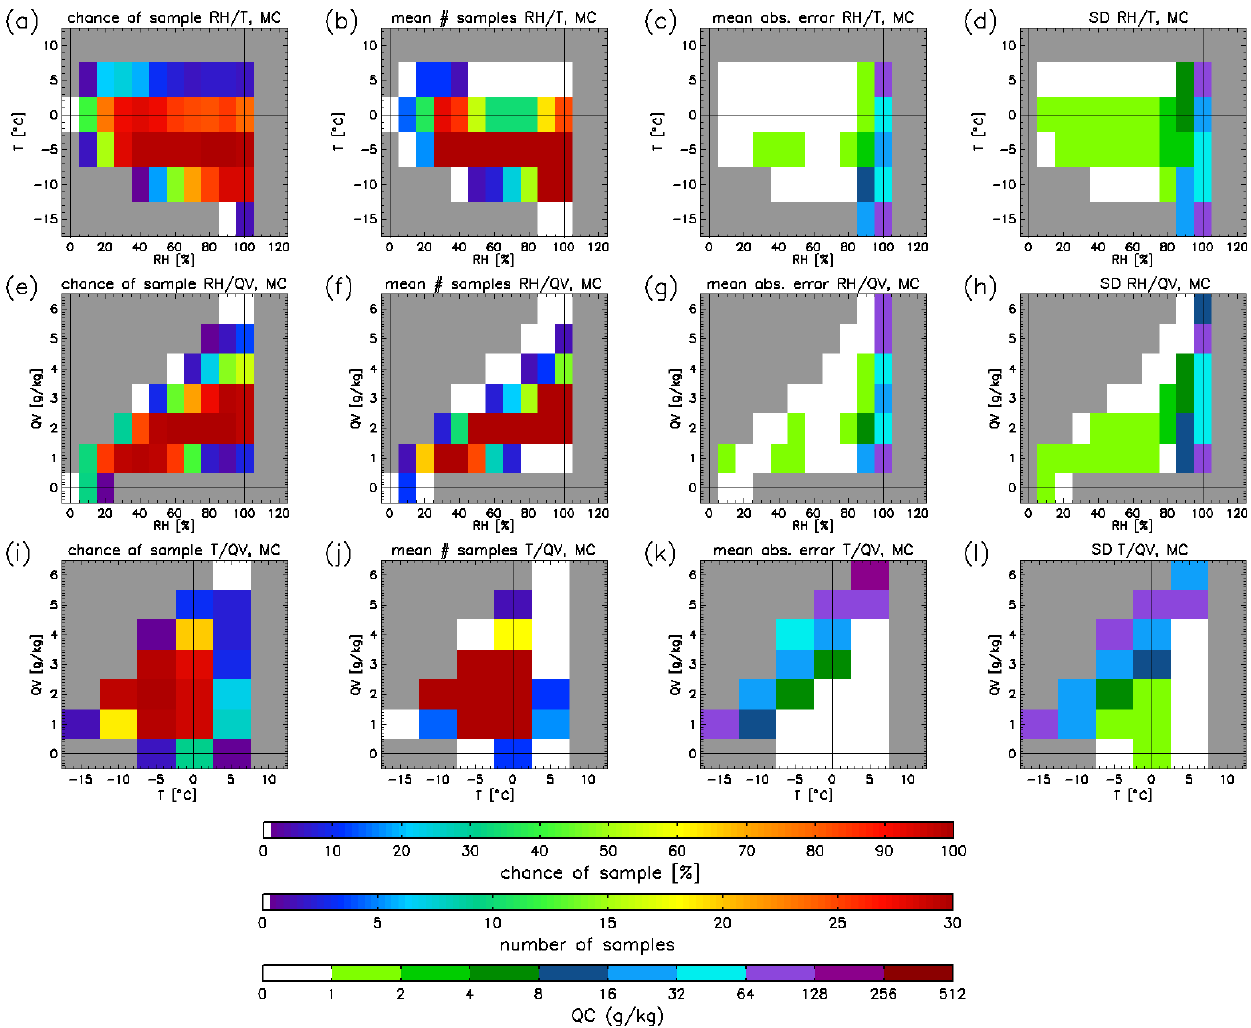
Figure 9. (a–d) Results of the random sampling experiment, which are divided by each thermodynamic regime specified by relative humidity and temperature. Panel (a) shows the chance of a regime being sampled during a single trial set of eight flights; (b) is the typical number of samples collected from each regime during a single trial, (c) is the mean absolute error of all trial QC values relative to the population QC values, and (d) shows the standard deviation of the QC values for all trials. (e–h) Same as (a–d) , but for regimes characterized by water vapor specific and relative humidities. (i–l) Same as (a–d) , but for regimes characterized by temperature and specific